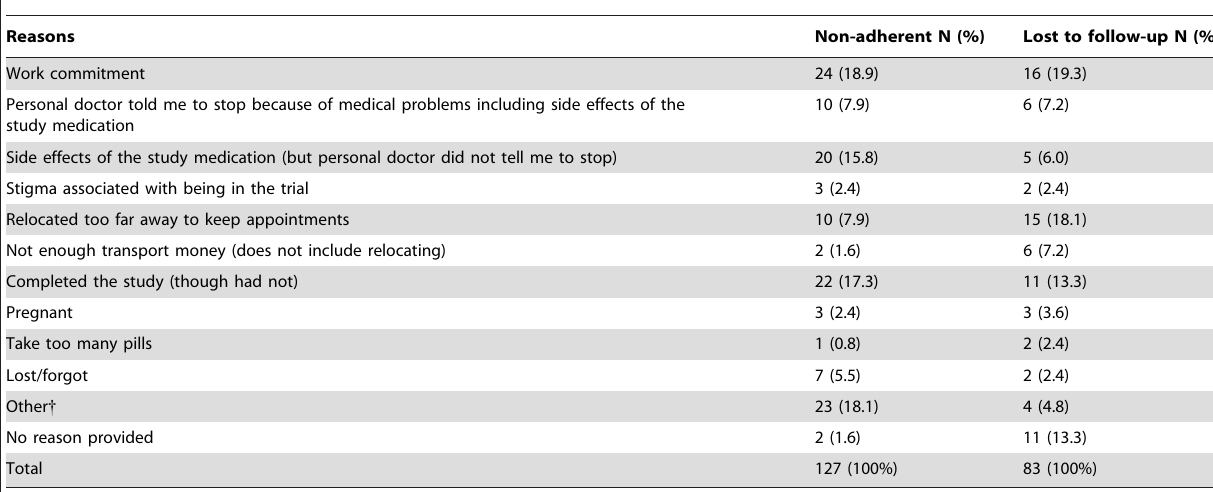
Table 5. Self-reported reasons non-adherent and loss to follow-up cases stopped taking isoniazid medication in the Botswana Isoniazid Preventive Therapy